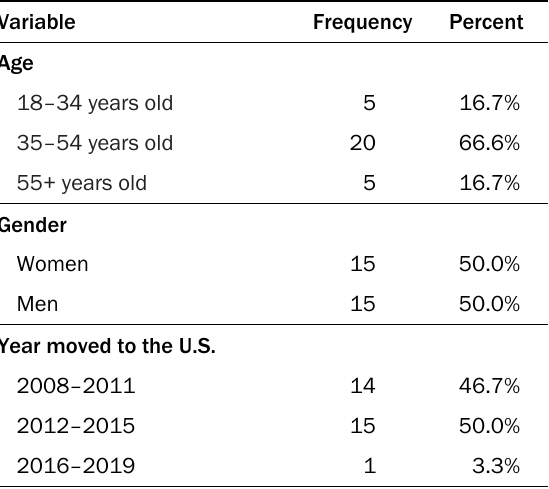
Table 1. Interview Demographics ( n